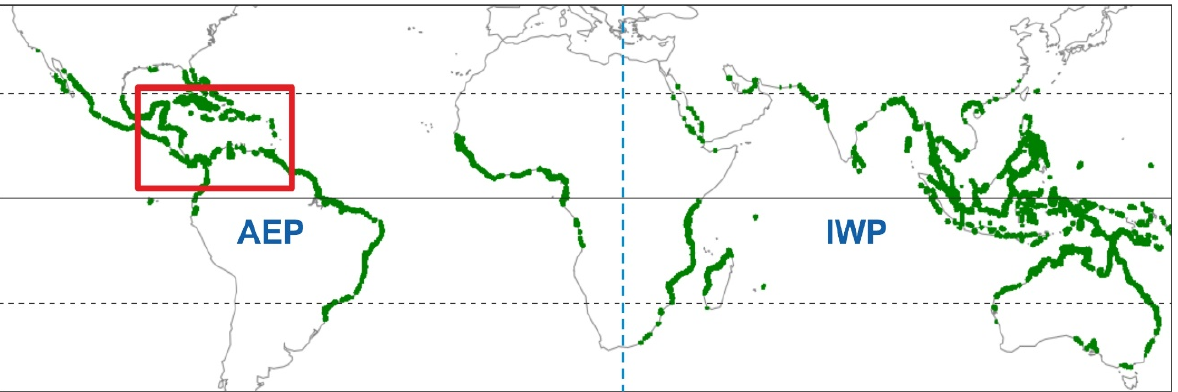
Figure 1. World map of mangroves (green fringes) indicating the Caribbean region (red box). The African continental barrier between the Atlantic-Eastern Pacific (AEP) and Indo-West Pacific (IWP) regions is represented by a dotted blue line in the center. Base map from Ref. [1].